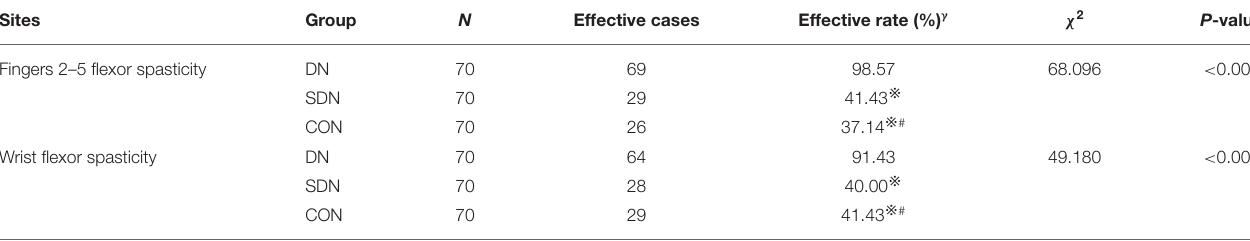
TABLE 3 | Effective rate of spasticity relief from baseline to after each treatment in fingers 2–5 and wrist. Sites Group N Effective cases Effective rate (%) γ χ 2 P -value Fingers 2–5 flexor spasticity